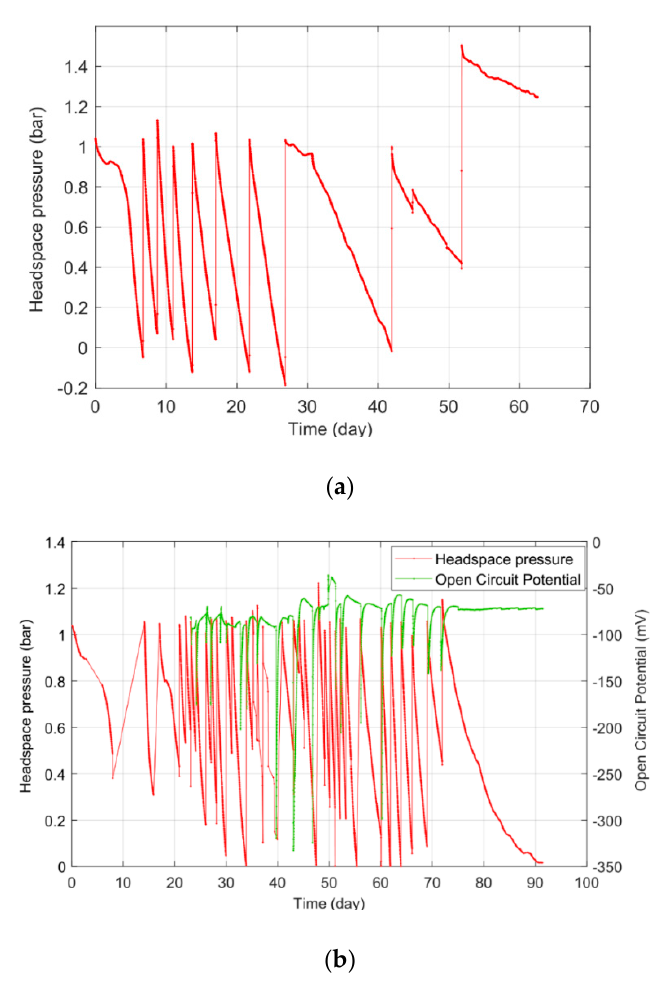
Figure 1. ( a ) The Phase 1 headspace pressure time series; ( b ) the Phase 2 headspace pressure time series and OCM at the cathode vs. the reference electrode (Ag/AgCl, 3 M NaCl).